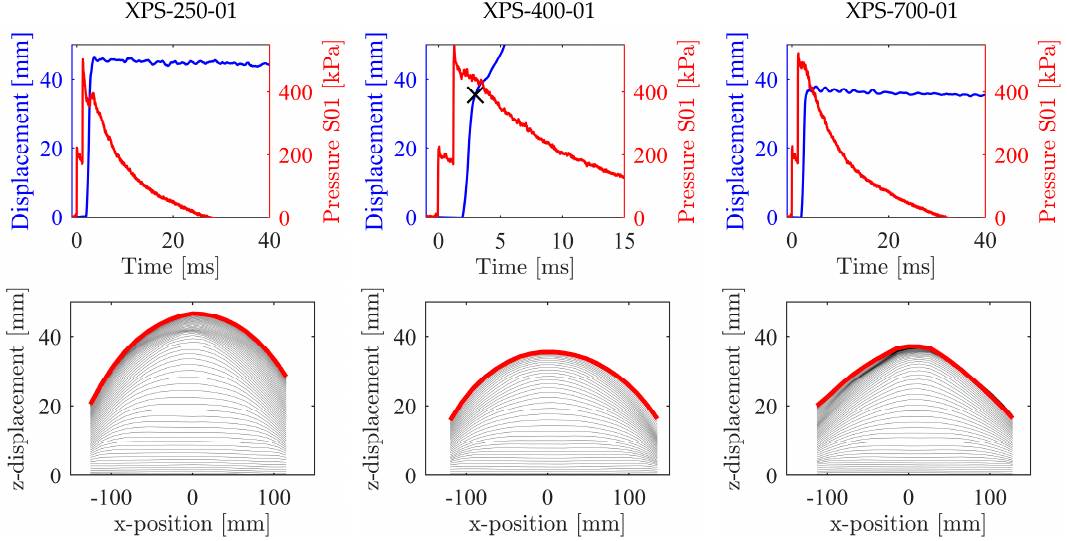
Figure A2. Displacement and pressure versus time (top) and displacement profiles (bottom) for tests on sandwich panels with 15 bar firing pressure, Series 1.